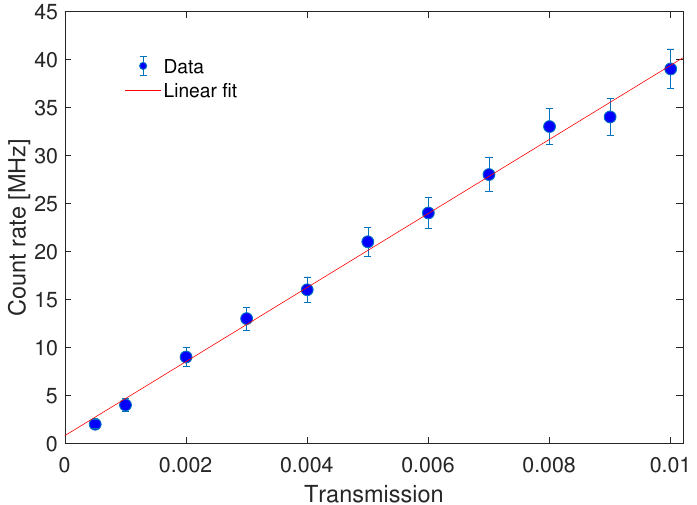
Figure 4. Correlation between the APD count rate and X-ray transmission after the aluminum filters at relatively low count